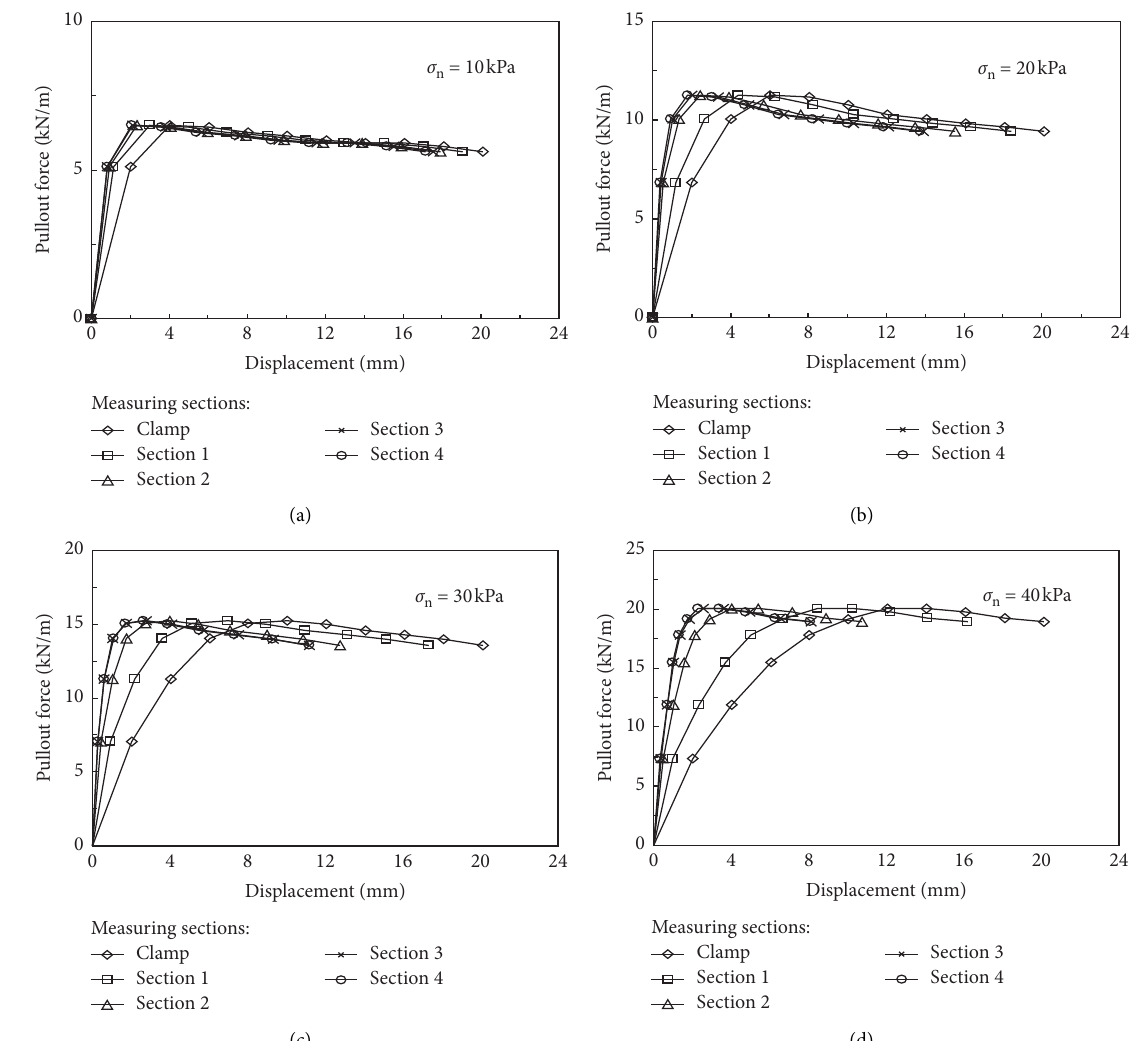
Figure 8: Relationship between pullout force and displacements of measuring